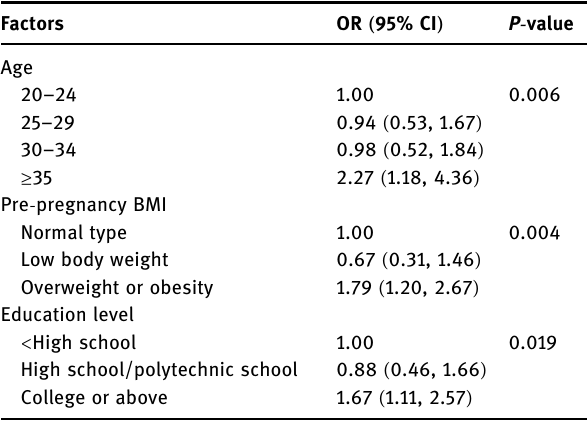
Table 8: E ff ect of factors on GDM ( four trimesters )